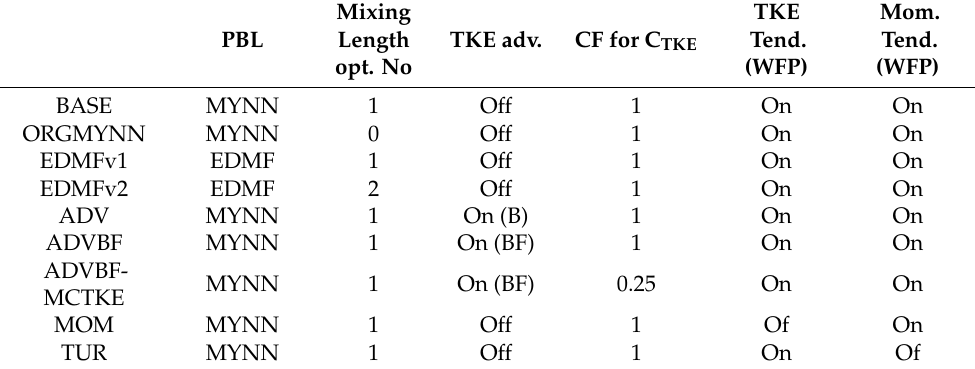
Table 2. Descriptions of the main simulations. The red font color indicates the additional simulations not involved in the evaluations but providing contributions to the WFP’s components to wind farm wake impacts. The second column is the choice of MYNN scheme, regular MYNN scheme, or EDMF scheme. In the column of TKE advection (TKE adv.), parentheses for enabled TKE advection represent bugged (B) and bug-free (BF) versions. In the next column, CF represents the correction factor for C TKE . In the next two columns, it is shown whether WFP’s TKE and momentum tendency components are disabled. Mom. Mixing TKE Tend. PBL Length TKE adv. CF for C TKE Tend. opt. No (WFP)